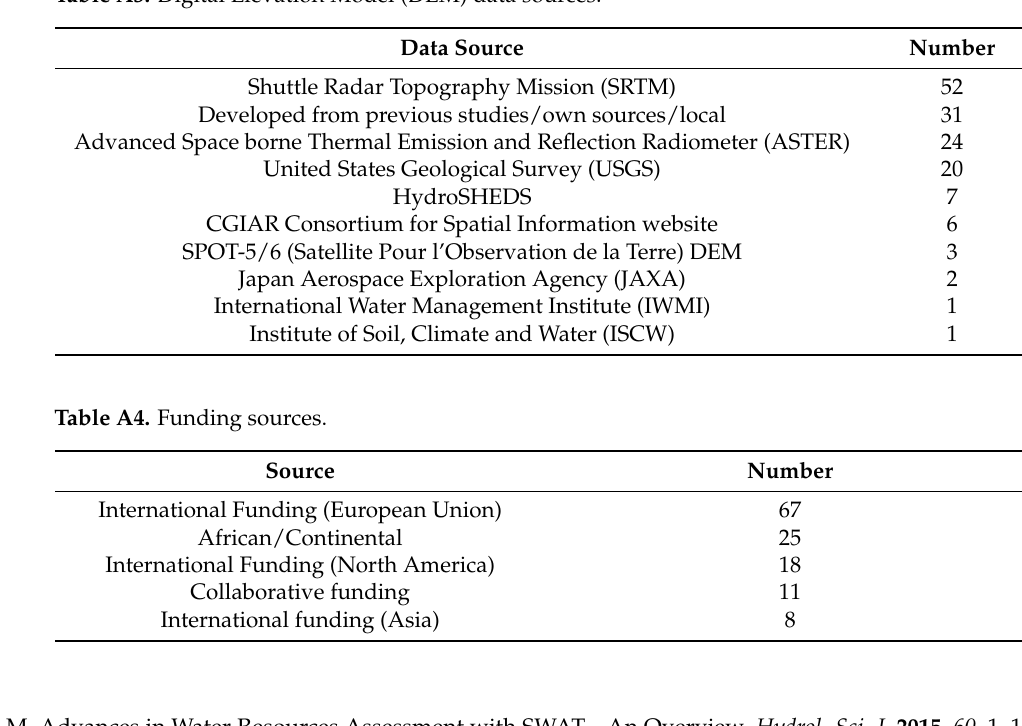
Table A3. Digital Elevation Model (DEM) data sources.